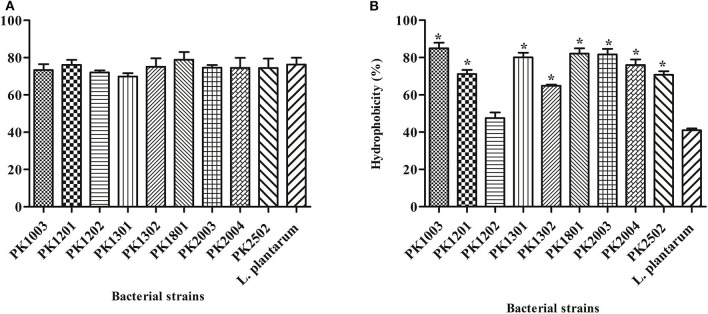
Adhesion of E. faecalis isolates and L. plantarum ATCC 14917 to a human cell line. (A) Adhesion ability. (B) % Hydrophobicity. Error bars indicate the standard deviation of three independent experiments. *p < 0.05.